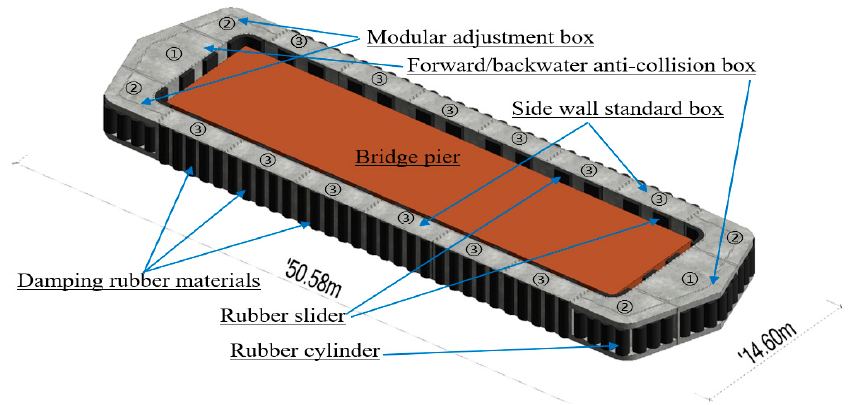
Figure 1. Plane layout of the new type of UHPC collision avoidance.